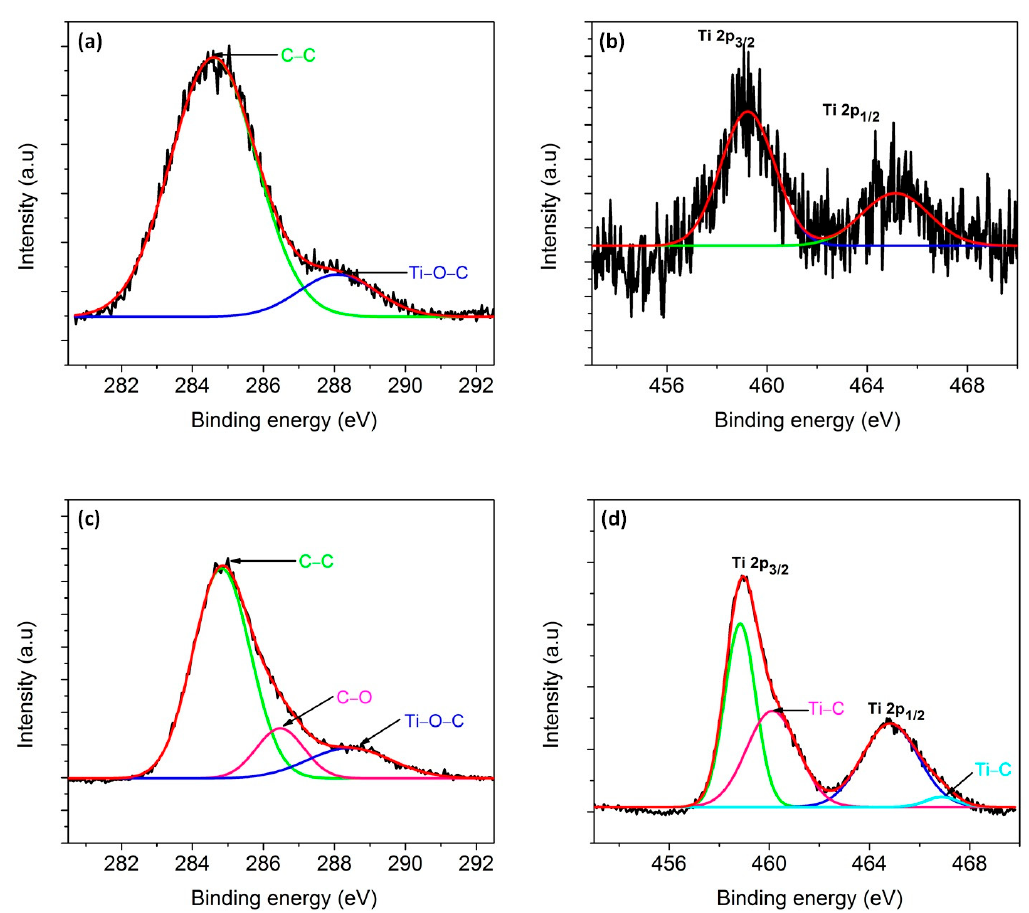
Figure 14. XPS peak deconvolution of C(1s) and Ti(2p): ( a , b ) in macroporous and ( c , d ) mesoporous